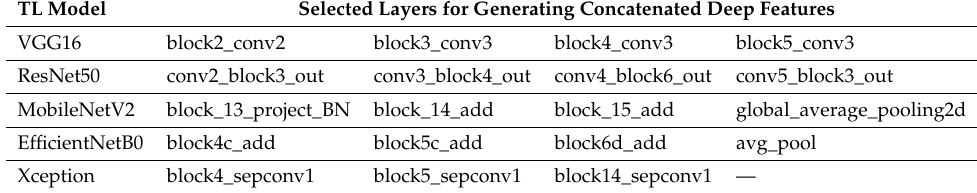
Table 1. Layers to concatenate deep features for five different transfer learning models. For all transfer learning models, four individual layers are selected for extracting features except Xception, where three layers are used for feature